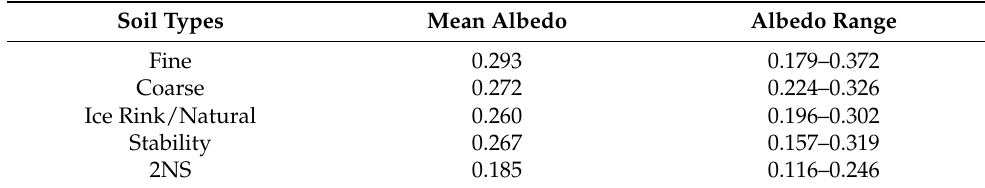
Table 2. Table of albedo mean values and ranges for each soil.